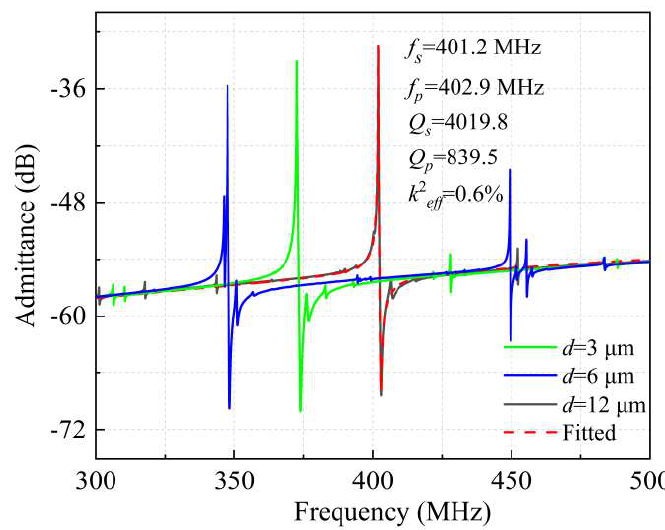
Figure 7. The measured admittance curves for the extended lateral reflection boundary width of 3 µ m, 6 µ m and 12 µ m, and the MBVD fitting curve as d = 12 µ m. The Q s values and k 2 eff are important parameters for the LWRs, and both of them were extracted based on the measured results by using Equations (5) and (6) [22]. The Q s value and the k 2 eff of the LWR with d = 12 µ m were up to 4019.8 and 0.6%, respectively. For the LWRs with d = 3 µ m and 6 µ m, however, the Q s values decreased to 3726 and 2870, and the k 2 eff were 0.84% and 0.59% with no significant variation. The k 2 eff of the LWR with d = 12 µ m was slightly lower than that of the other two LWRs. On the one hand, the widening of the reflection boundary suppresses the spurious modes and also suppresses the main mode to a certain extent. On the other hand, the 8th-S0 mode is transformed into other smaller spurious modes affected by the longitudinal mode, which will cause a decrease in the k 2 eff of the main mode. As d = 12 µ m, the 8th transverse spurious mode is effectively suppressed due to its ideal harmonic condition, which helps to obtain the pure spectrum. Moreover, the static displacement points are evenly distributed in the middle of the IDTs, which minimizes the interface loss and acoustic loss. Therefore, the designed LWR with d = 12 µ m can achieve the highest Q values, which is consistent well with the above simulation results.